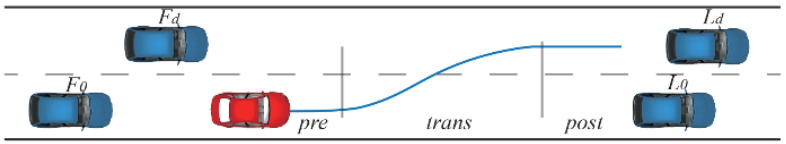
Figure 4. The three stages of the lane-change